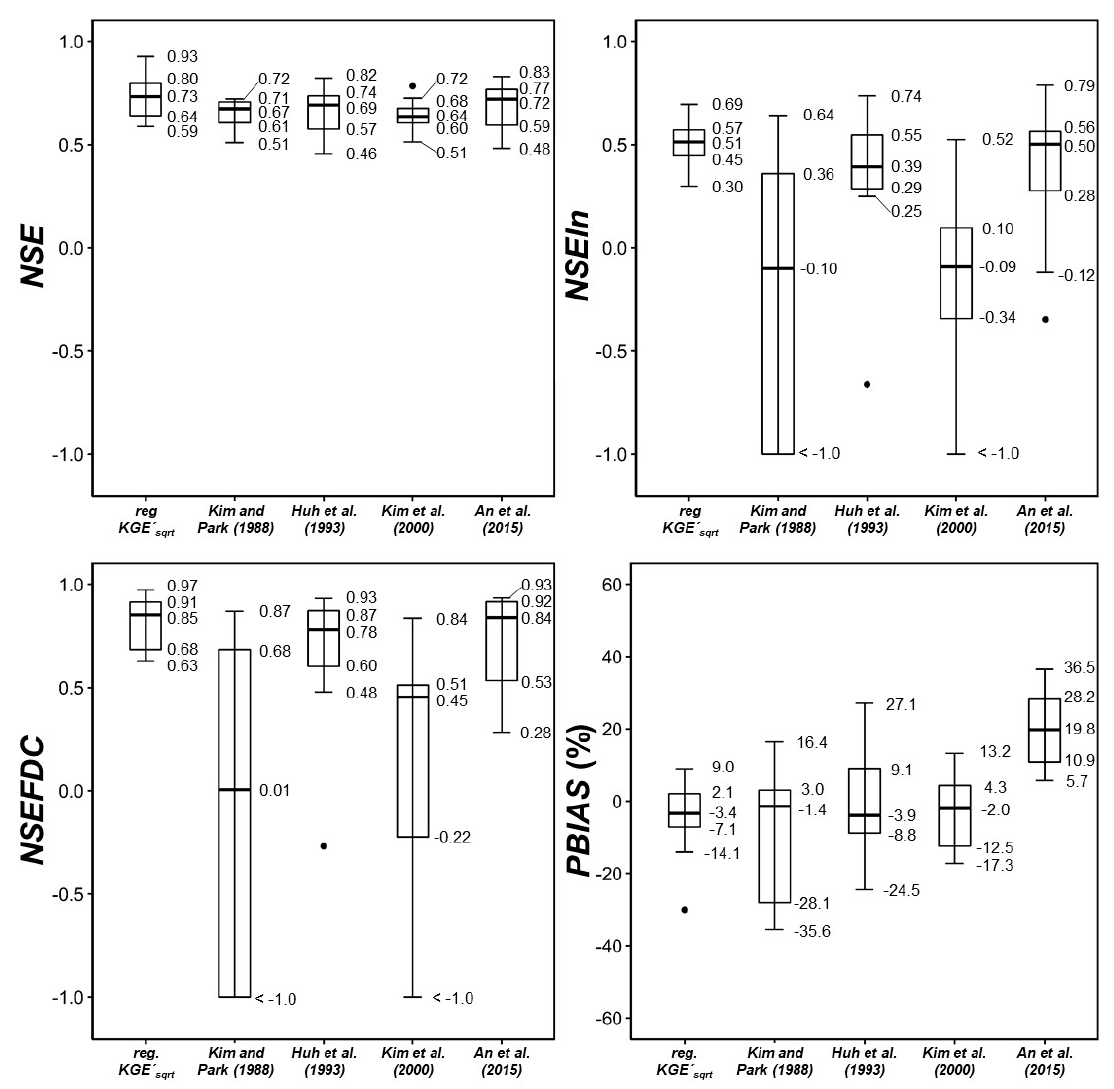
Figure 8. Variation of performance statistics ( NSE , NSEln , NSEFDC , and PBIAS ) provided by regRMSE and other regional models for 10 verification watersheds.